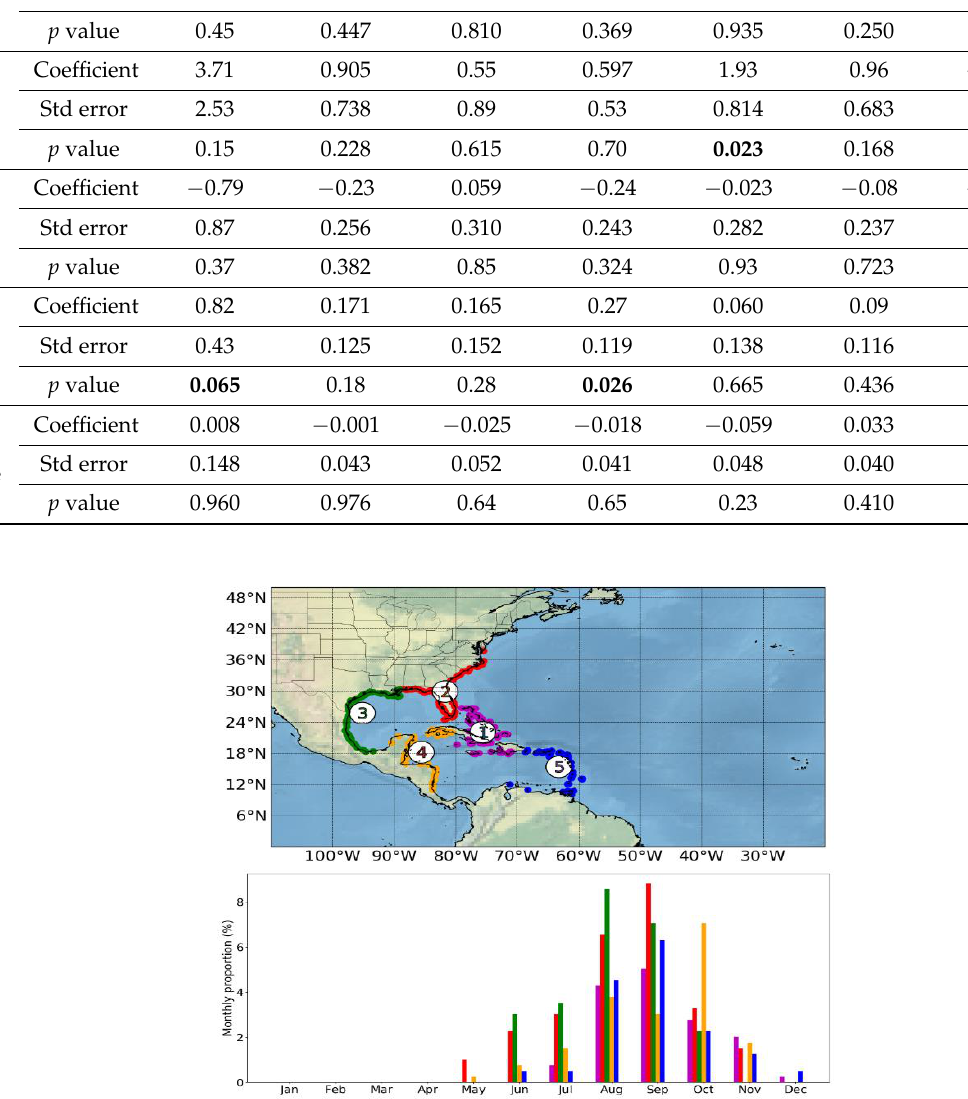
Figure 5. Map representation of TC landfalling regions ( top ) and monthly proportion of landfalling for each cluster ( bottom ). The monthly proportion was computed as the proportion of landfalling count in a month for a cluster and the sum of total landfalling (L 1 + . . . + L 5 ) (1980–2019). Note that landfalling on the east coast of the United States from 40 ◦ N latitude and those that occurred on the islands located in the central North Atlantic were not considered.